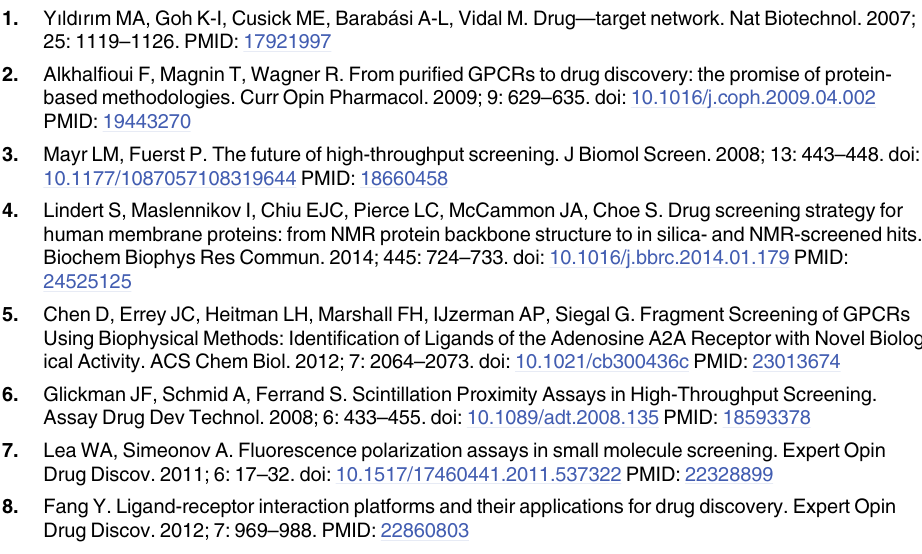
S2 Fig. SDS-PAGE detection of KOR, uncropped and unadjusted gel lanes. A) Coomassie brilliant blue staining. B) Western blot detection with streptavidin alkaline phosphatase bind- ing to the C-terminal biotin-tag of KOR. S1 Table. Identification of KOR by MALDI mass spectrometry. Sequence coverage was 7% and the protein was identified as kappa-type opioid receptor isoform 2 (Homo sapiens), which suggest that the identified protein was